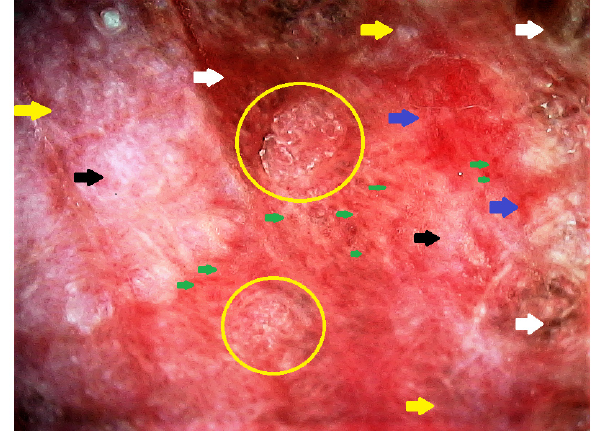
Figure 4. Dermoscopic image from dorsum of the tongue displaying tri-color pattern constituted by 1) Modified Wickham’s striae appearing like structureless veil-like grey-white (black arrows) to bluish-white areas (yellow arrows), which have also been called leukoplakia-like areas (LLAs) and speckled pearly appearance (yellow circles); 2) bright red slightly depressed areas suggestive of erosions (blue arrows), and 3) interspersed violaceous-to-brown clods (white arrows) suggestive of pigment incontinence. Scattered dotted as well as linear to curvilinear vessels (green arrows) present along the borders of the junction of ‘white’ and ‘red’ areas. (Escope Videodermoscope, 20×, polarized mode). The blunting of lingual papillae is better appreciated on comparison with Figure